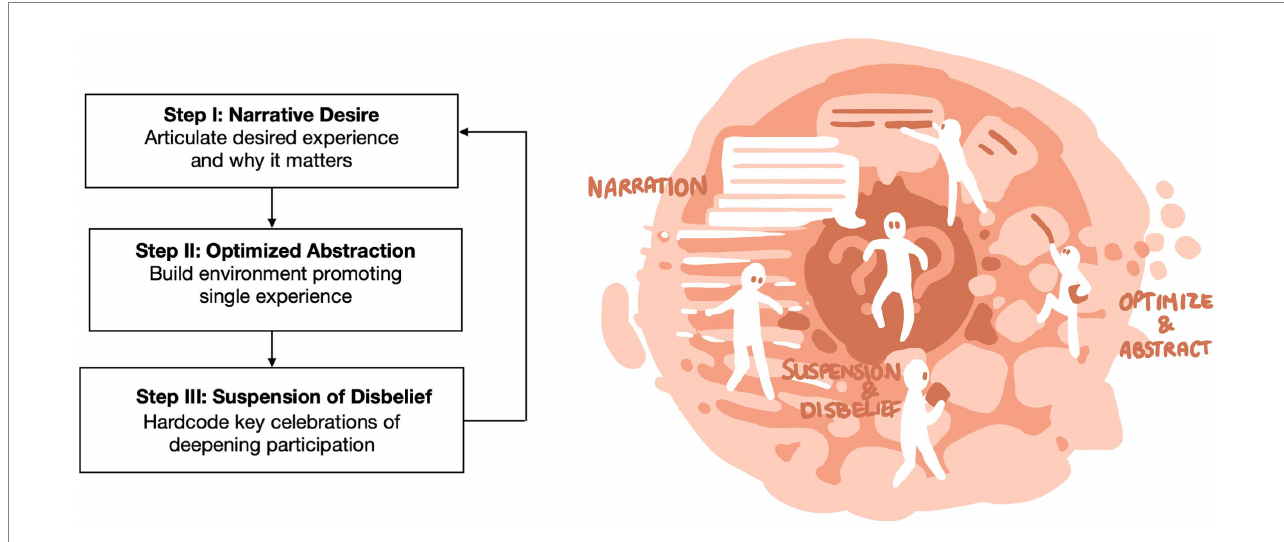
FIGURE 2 Three-step approach to design for liminal